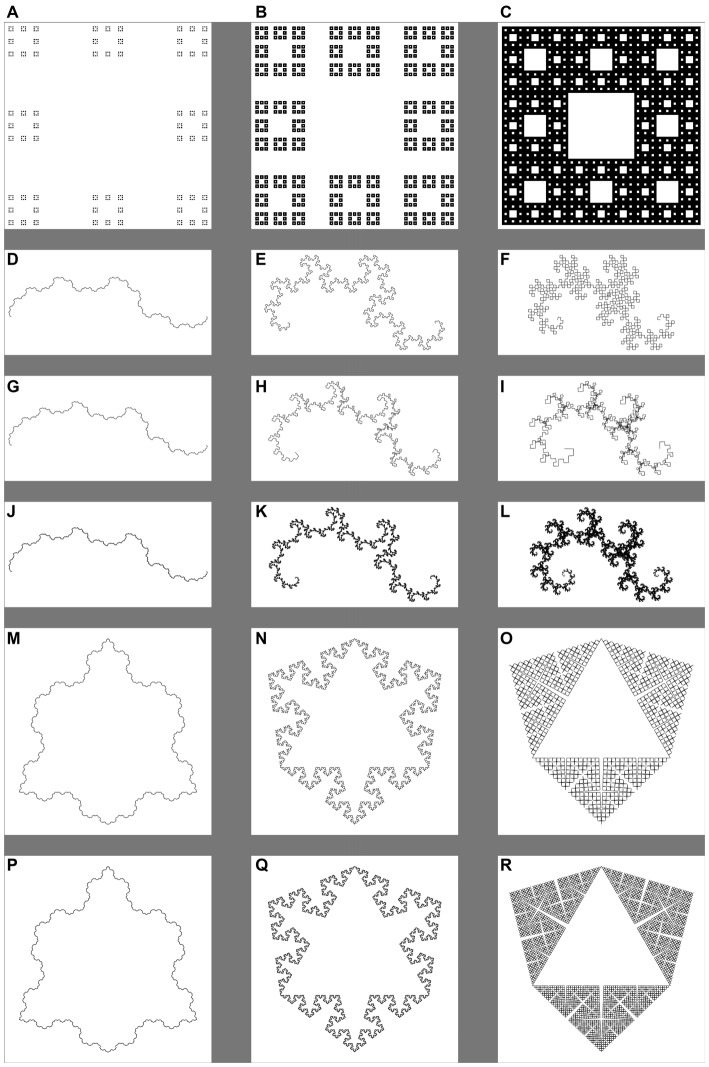
Exact fractals that vary in generator rule, level of recursion and dimension. Each column shows a different level of dimension, such that the dimension of the fractals in columns 1 (A,D,G,J,M,P) 2 (B,E,H,K,N,Q) and 3 (C,F,I,L,O,R) is 1.1, 1.5, and 1.9, respectively. (A–C) Show Sierpinski carpets, where the middle 1/9th of the pattern has been removed at four scales. (D–L) Show dragon fractals that vary in symmetry recursion and dimension. (D–F) (Dragons) result from 10 levels of recursion with bisection of the segments at each level of recursion. (G–I) (Golden dragons) result from 10 levels of recursion with ratio a:b, where a = (1/φ)(1/φ) and b = a2, as the basis of the adjustment of each segment at each level of recursion. (J–L) (Golden dragons) result from 17 levels of recursion with the same rule as (G–I). (M-R) Show Koch snowflakes that vary in recursion and dimension. (M–O) Result from bisection of the segments of a triangle and bisection of each segment at each level of recursion for five recursions. (P–R) Are the result of an additional level of recursion (six recursions) applied to the snowflakes of (M–O).